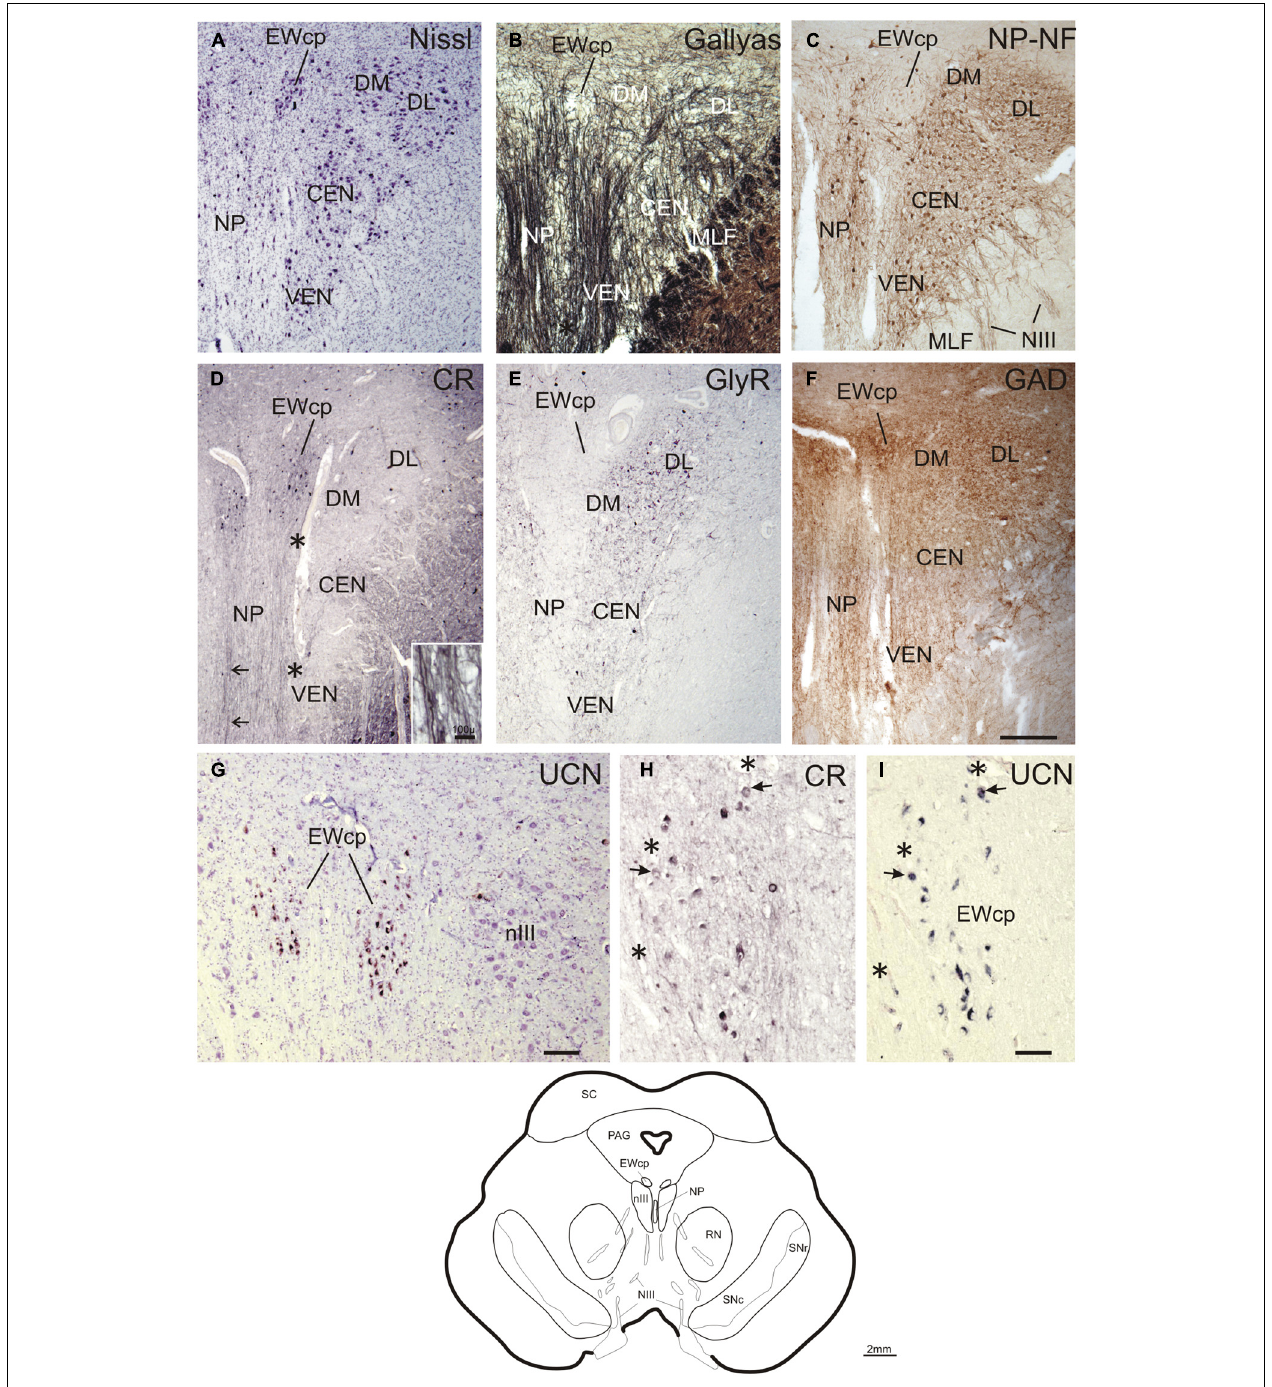
FIGURE 3 |Transverse sections at the level of the mid oculomotor nucleus (line drawing at the bottom). Cresyl violet (A) , fiber staining (B) , and immunostaining for non-phosphorylated neurofilaments (NP-NF) (C) reveal six subnuclei of the nIII complex at this level that exhibit different staining patterns for calretinin (CR) (D) , glycine receptor (GlyR) (E) , and glutamate decarboxylase (GAD) (F) .The nucleus of Perlia (NP) forms an elongated midline cell group separated from the main nucleus by dorsoventrally traversing fibers (A,B) , some expressing CR-immunoreactivity ( D , arrows, inset). At the dorsomedial border of nIII, a compact cell group